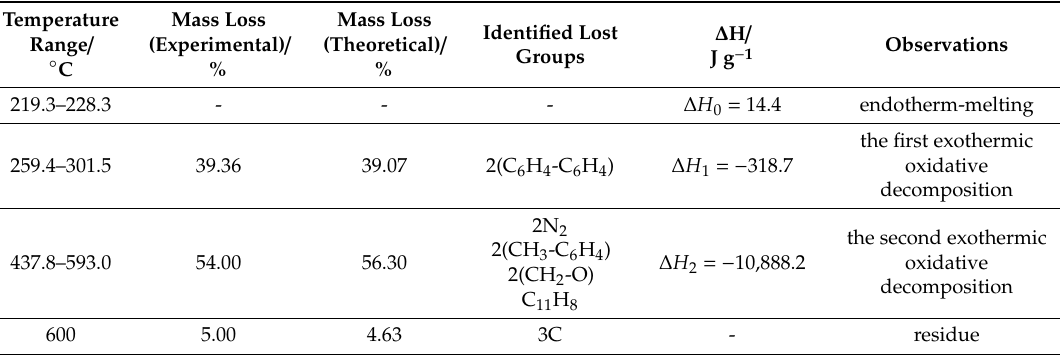
Table 14. Thermal analysis of